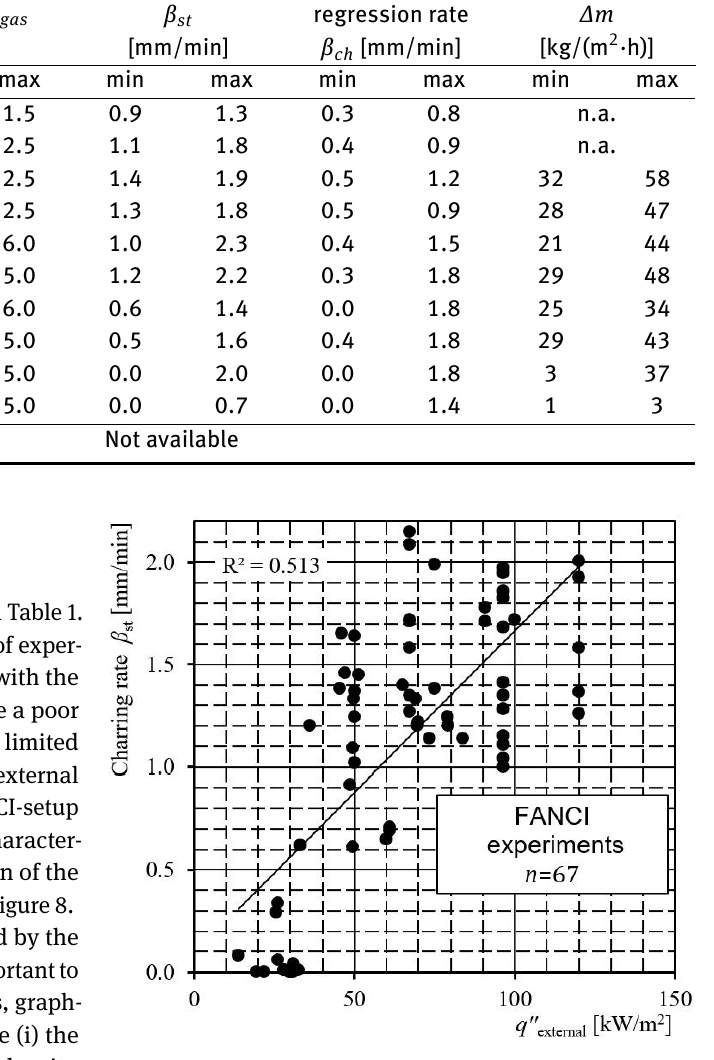
Figure 7: Observed charring rate vs. external heat flux and the correlation coeflcient (least squares